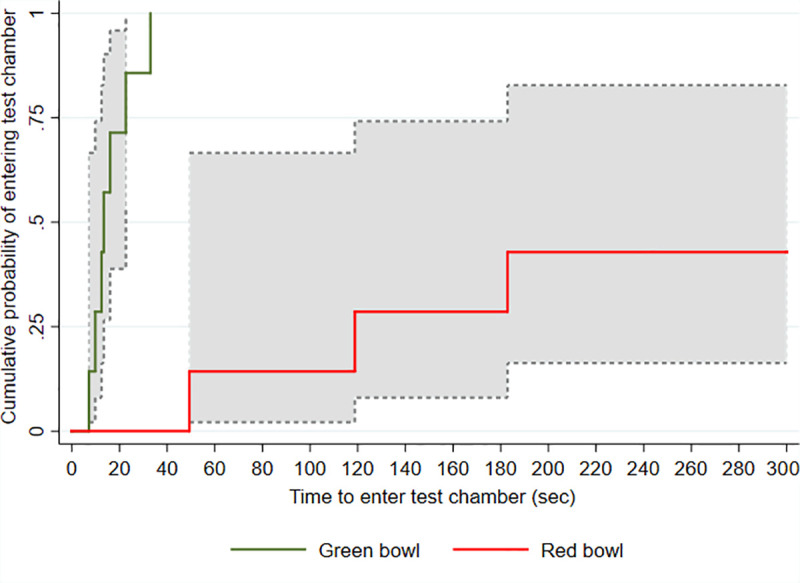
Kaplan-Meier graph of time taken for chickens to enter the test chamber when the red versus the green bowl was present and associated 95% confidence intervals indicated by dotted lines.